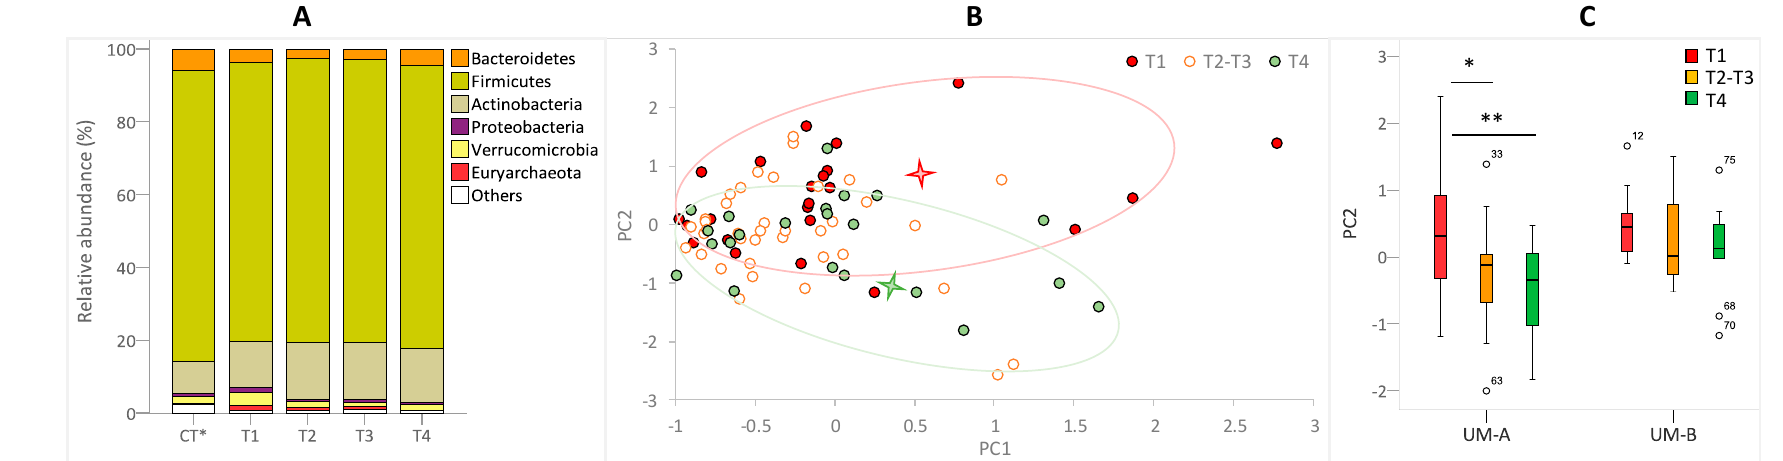
Figure 2. Microbial taxonomic composition in fecal samples of mothers through postpartum. ( A ) The bars show the mean proportion at the phylum level. T1: early lactation stage (3 weeks after delivery); T2 and T3: established lactation stage (4 and 6 months after delivery, respectively); T4: after lactation stage (12 months after delivery); Control (CT): healthy adult cohort ( n = 249) previously published [18]. ( B ) Principal component analysis (PCA) and clustering analysis that shows differences in fecal microbiome through postpartum. (C) Box plots of second axes of the PCA (PC2) through postpartum in UM-A and UM-B groups.